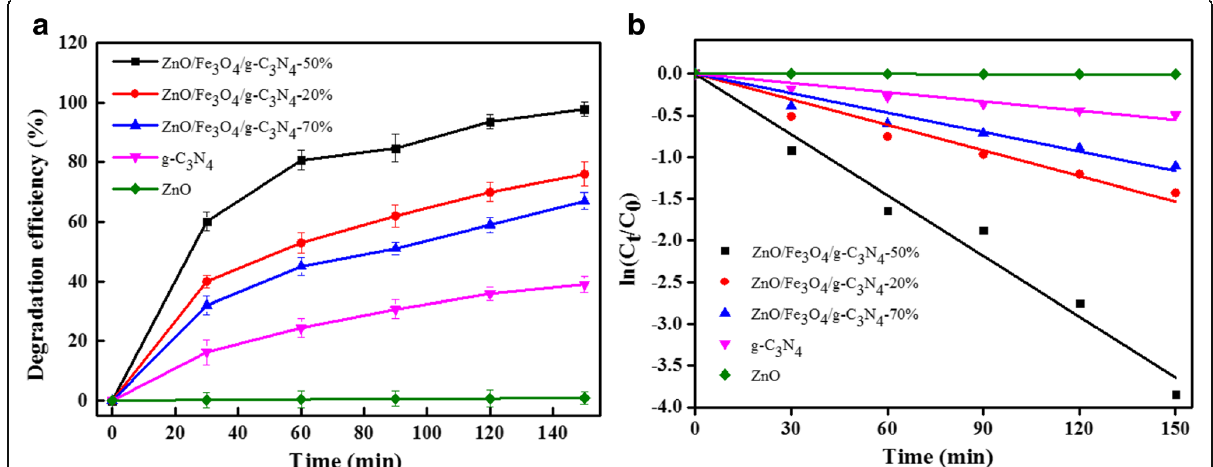
Fig. 9 Photocatalytic degradation efficiency ( a ) and kinetic curves ( b ) of MO over different photocatalysts under visible light irradiation, (the relative error of the data was less than 5%)